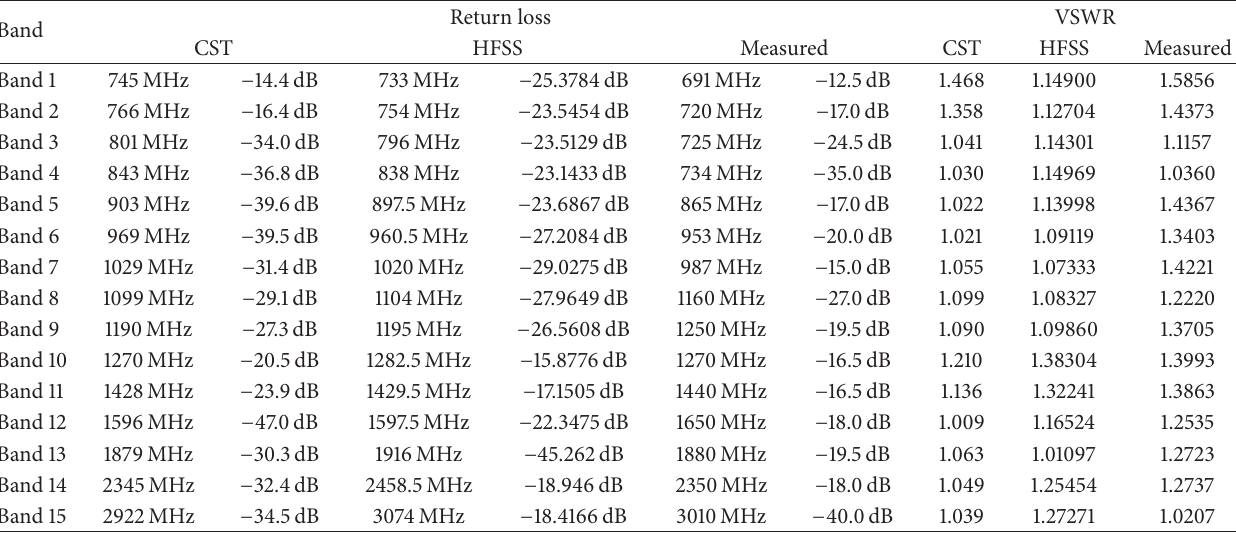
Table 7: Return losses and VSWR results of theoretical predictions versus measurement for TMFDB25